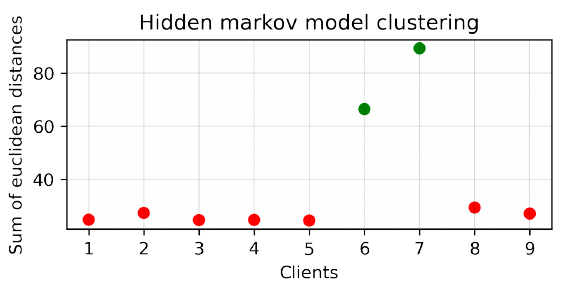
Figure 6. HMM clustering results for round 1. Here, red and green colours are used for different clusters.